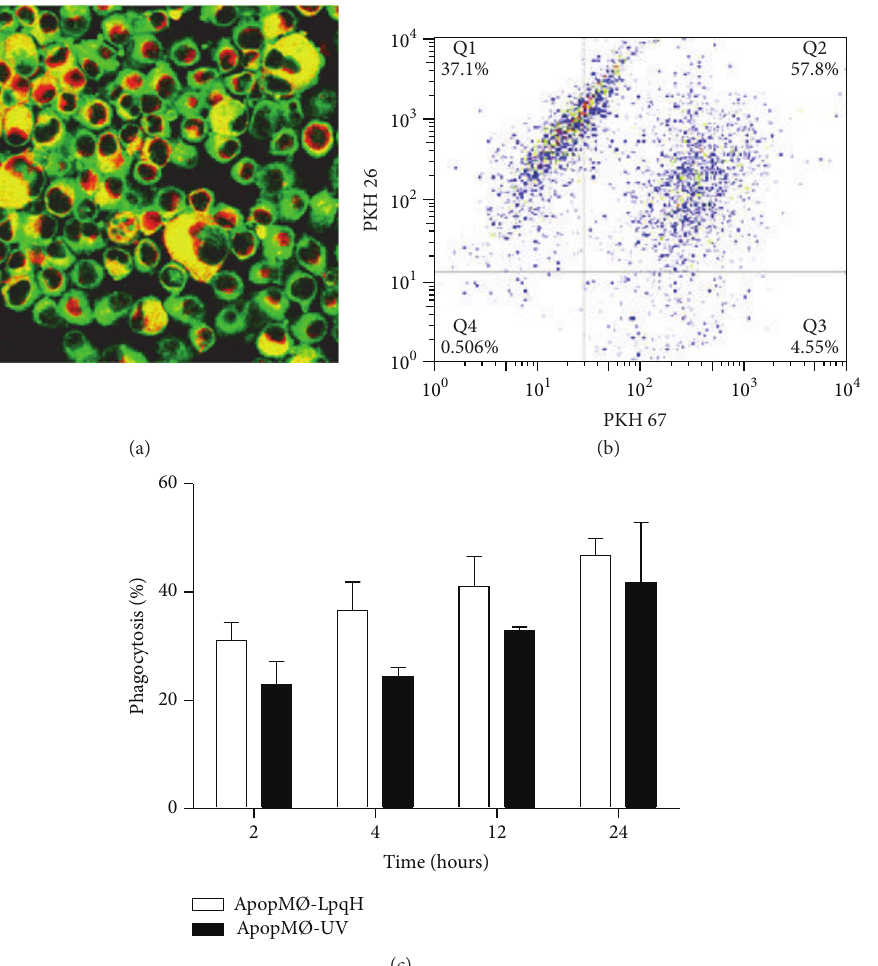
Figure 2: Phagocytosis of apoptotic macrophages assessed by epifluorescence and flow cytometry. We conducted phagocytosis assays with J- 774A.1 phagocytic cells labeled with PKH-67 (green fluorescence) and apoptotic MØs labeled with PKH-26 (red fluorescence). After two hours of incubation, in overlaid images, the confocal examination of mid-sectioned phagocytic cells showed enlarged MØs containing abundant yellow-fluorescent apoptotic bodies ((a), original 40x). Engulfed whole cells were not observed, perhaps due to their degradation within phagolysosomes. A representative dot blot shows double-labeled phagocytic cells in the upper right quadrant (b). Phagocytosis was quantitated by flow cytometry (c). Time-dependent phagocytosis was observed; that is, greater levels of apoptosis were observed at 24 h (47.7%). The results of three independent experiments are